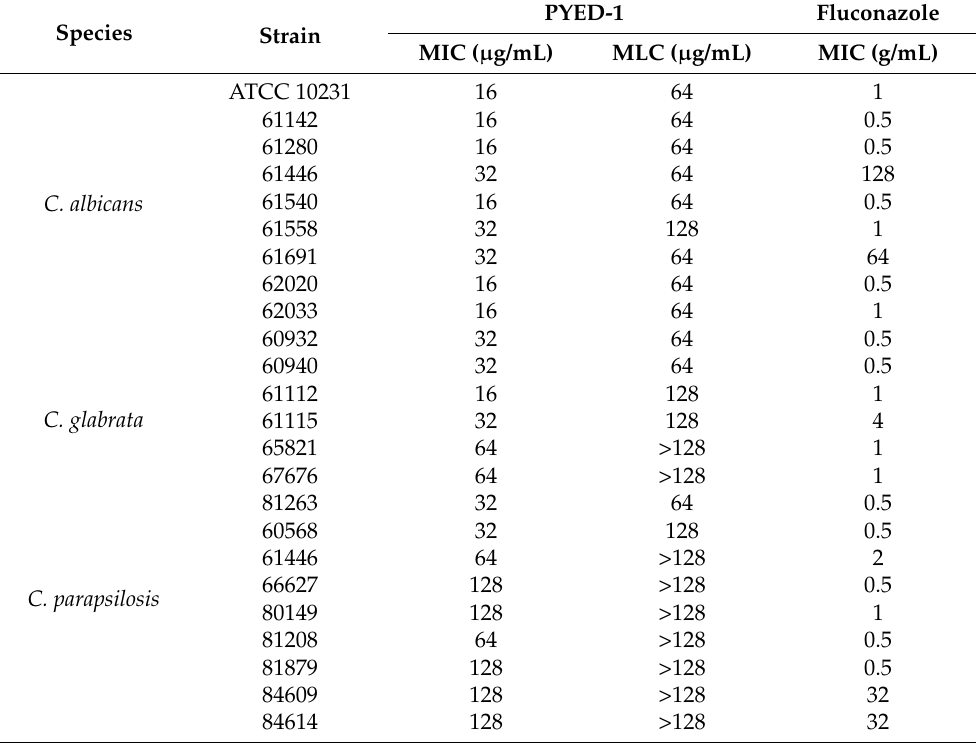
Table 1. Minimal inhibitory concentration (MIC) and minimal lethal concentration (MLC) of PYED-1 against Candida species.